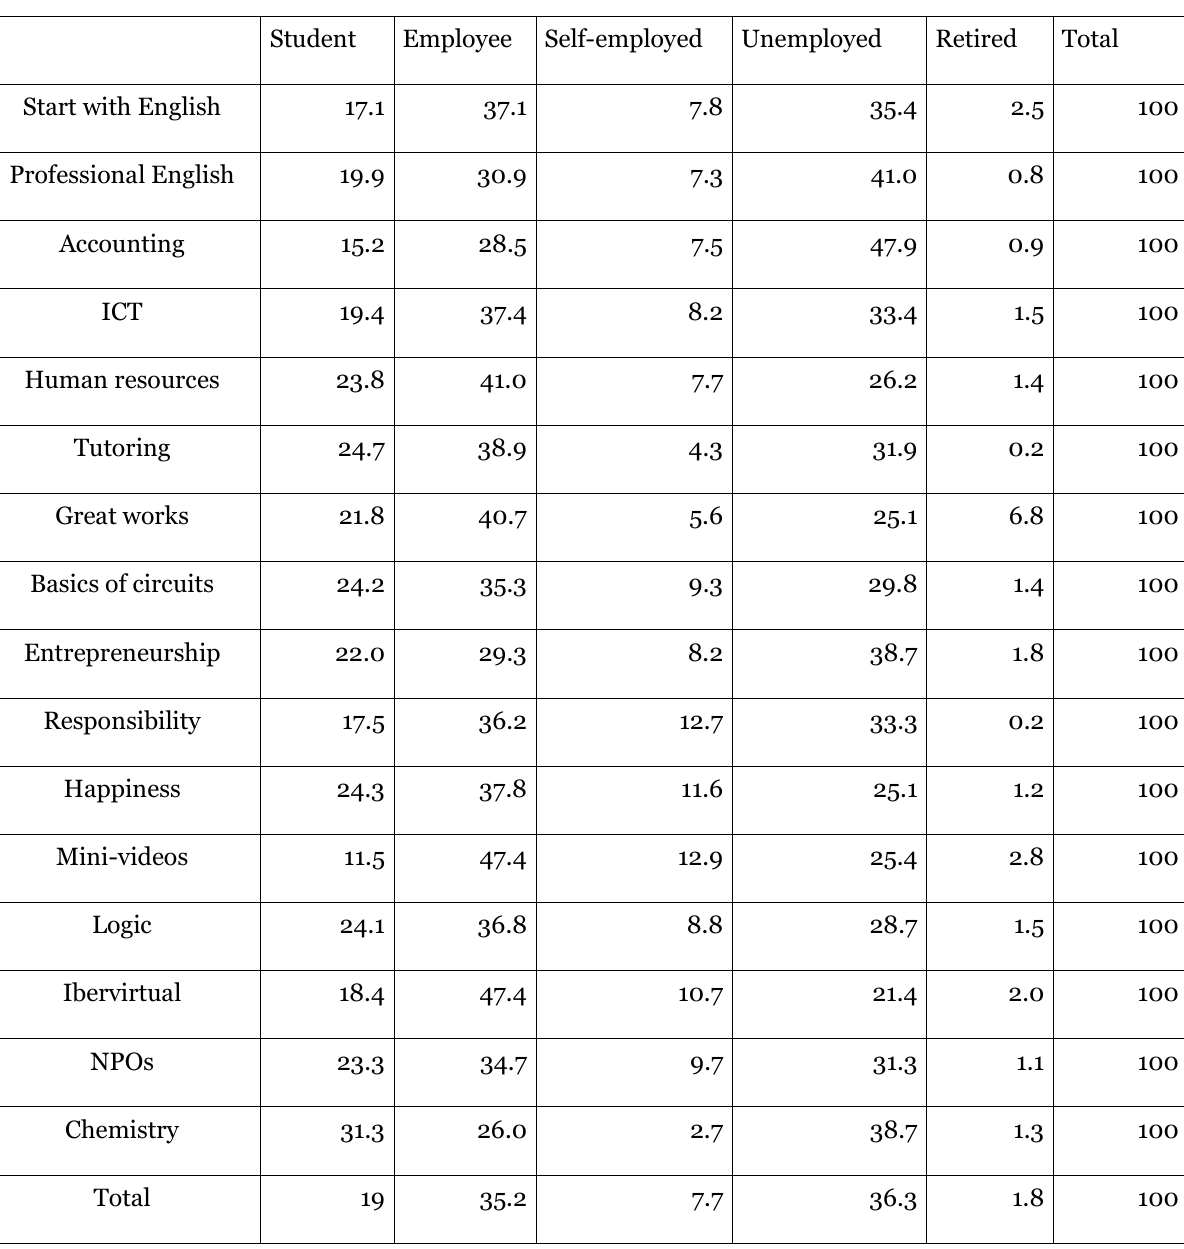
Learners' Employment Status